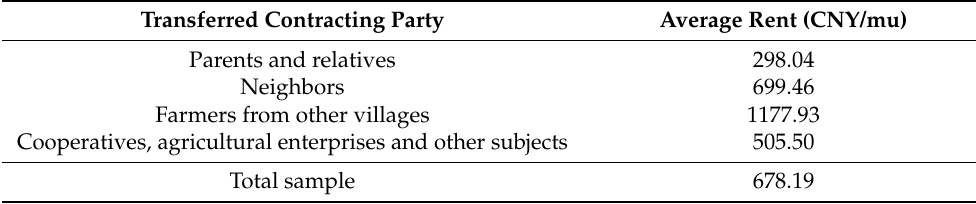
Table 5. Descriptive statistics of rent levels of different transfer contract